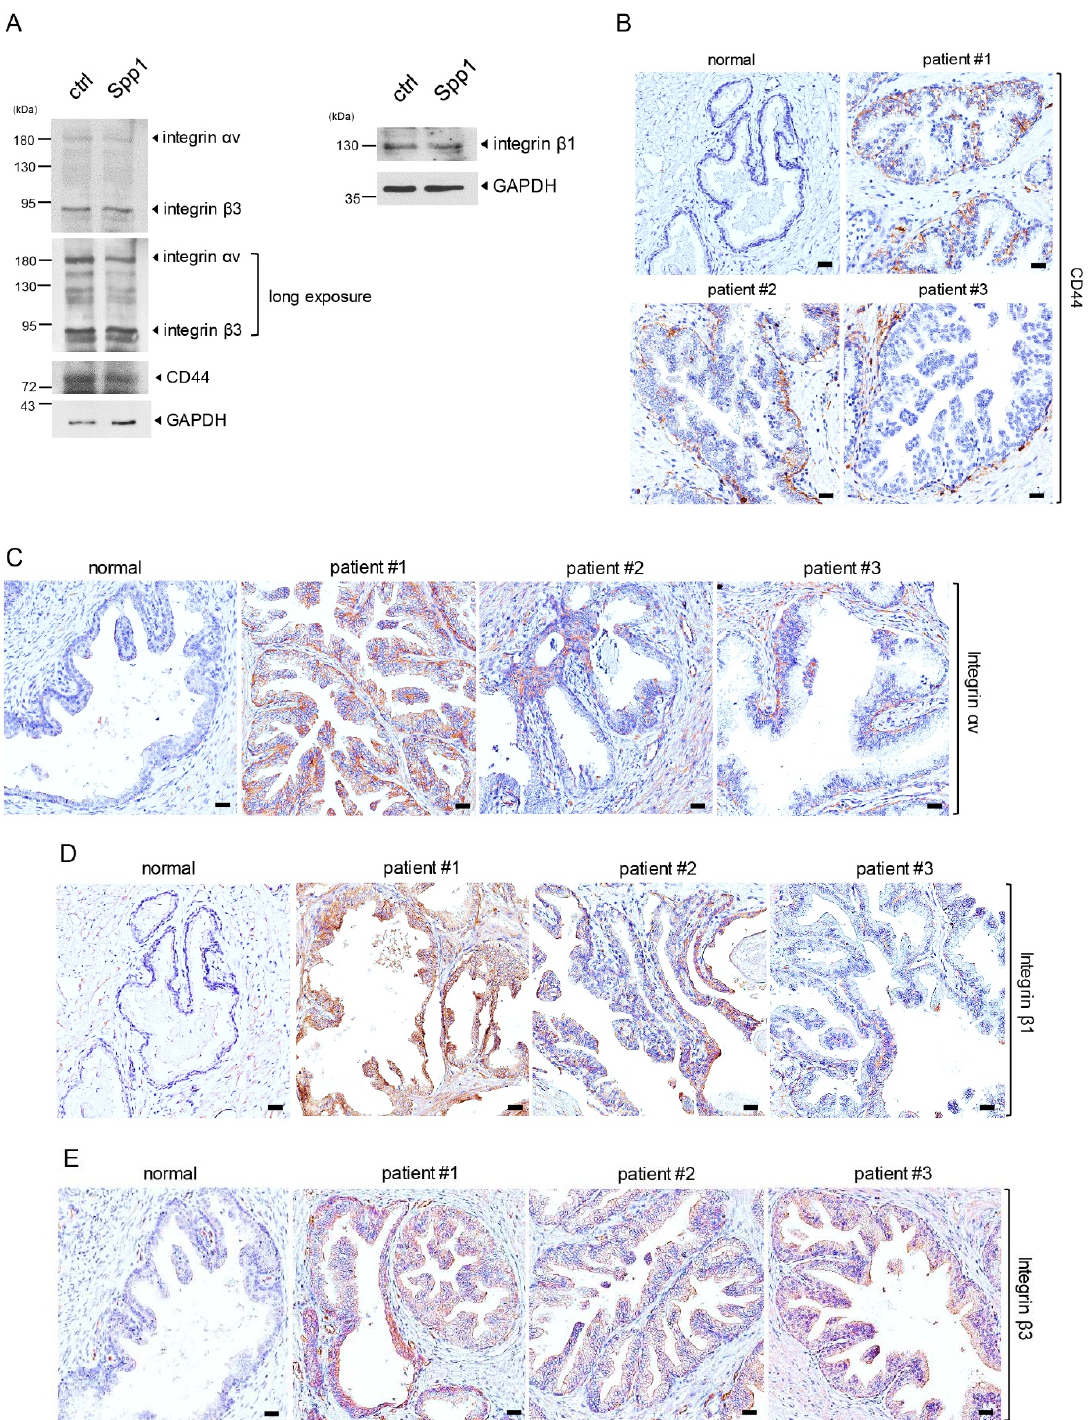
Figure 3. Expression of Spp1 receptors in PIN cells. ( A ) Cell lysates from murine PIN Pr111 cells grown on Matrigel in 3D treated with recombinant Spp1 or control for 72 h were subjected to immunoblotting for assessment of the Spp1 receptors, including integrin α v β 3, integrin β 1, and CD44. Long exposure: longer time to catch the emitted signal from the WB membrane on the X ‐ ray film. ( B – E ) Human tissue samples of normal prostate and prostate cancer containing PIN areas were immunostained for the expression of CD44 ( B ), integrin α v ( C ), integrin β 1 ( D ), and integrin β 3 ( E ). Scale bar: 50 μ m. the image shown here is representative of at least 3 independent experiments or tissue samples.